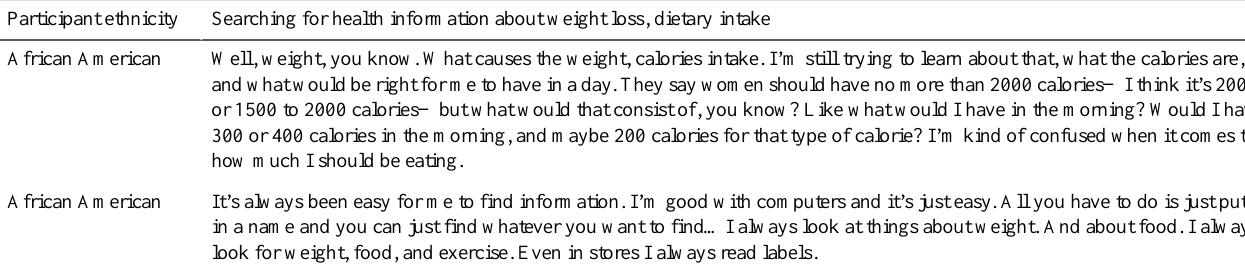
Table 4. Content theme: Additional health information sought by African American.